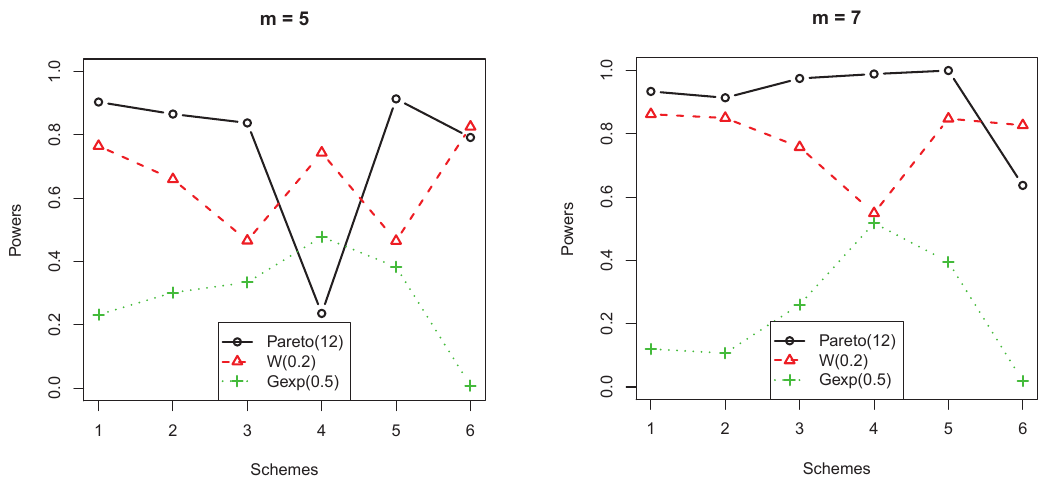
Figure 2. Powers of different schemes for the monotone decreasing hazard function for the ˆCKL test, in the case of n = 10, m = 5 and 7.